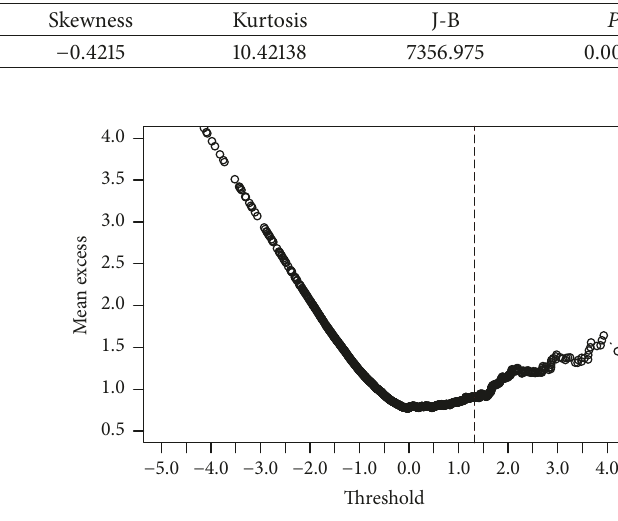
Figure 4: Excess mean value